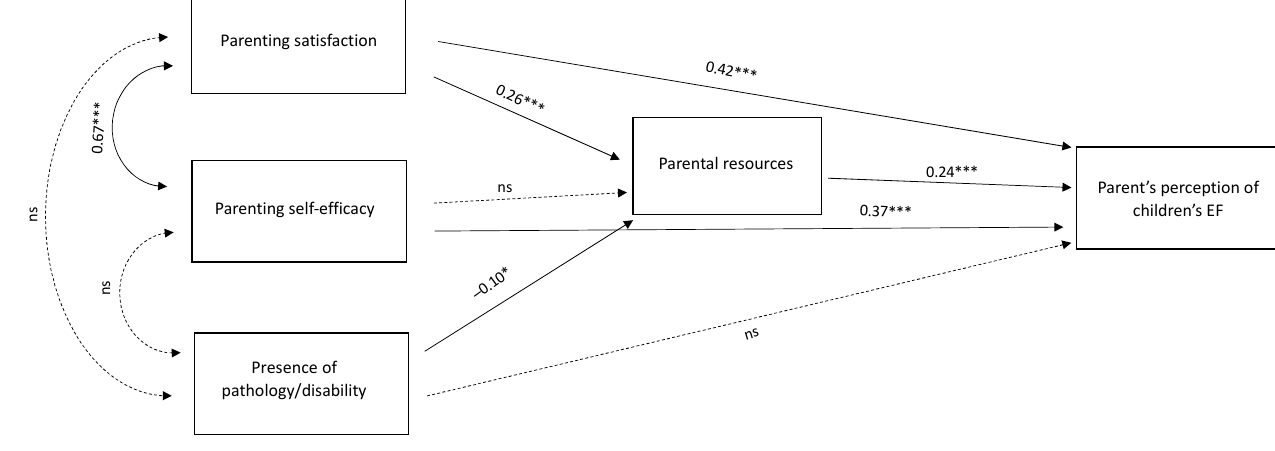
Figure 1. Path analysis model. *** p < 0.001, * p < 0.05.